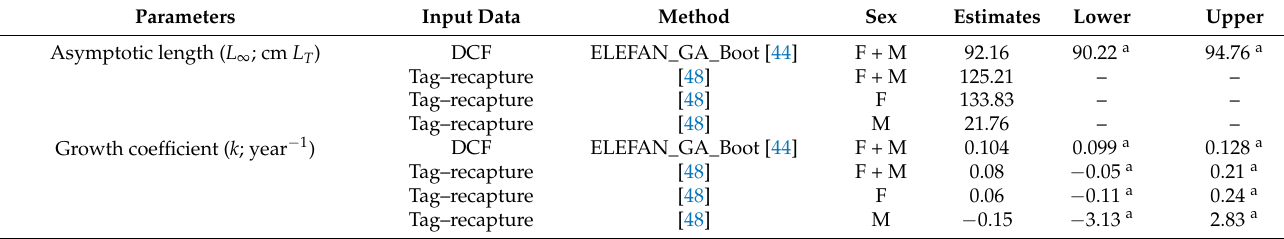
Table 2. Growth and fishery parameters for the thornback ray Raja clavata in the Azores estimated from L T –frequency data for the period 2010–2016. DCF: data from the EU Data Collection Framework. F + M: combined sexes. F: females. M: males. Lower and upper denote (a) 95% confidence interval, (b) standard deviation, or (c) standard error limits of the estimates. Parameters